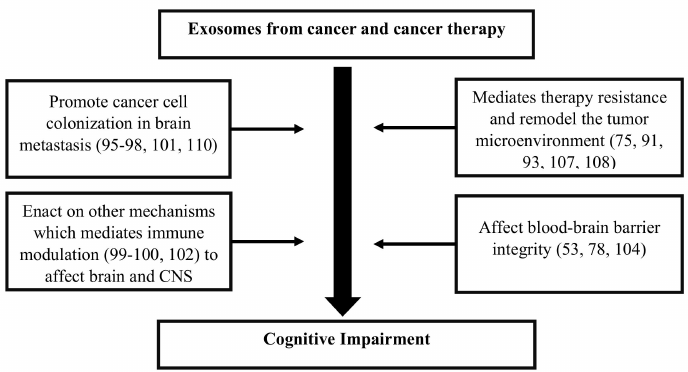
Figure 3. Flow diagram describing the potential role of exosomes and their ability to influence the microenvironment of the brain and central nervous system (CNS), which causes cognitive impairment in cancer